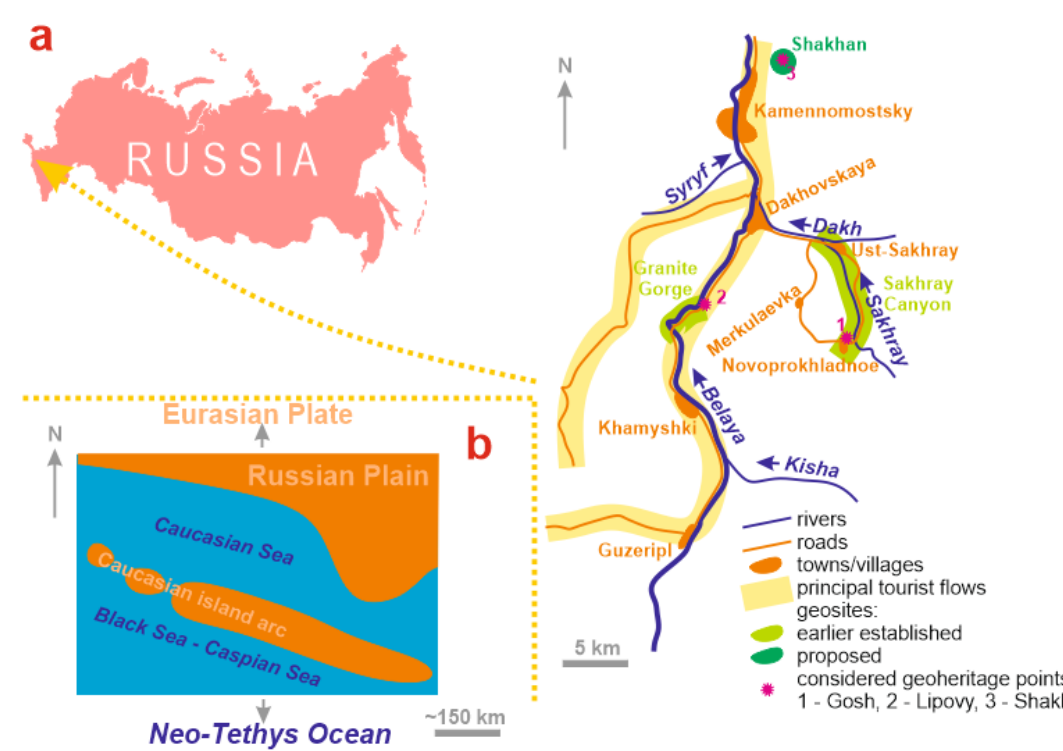
Figure 1. Geographical location of the study area, with focus on touristic infrastructure and geoheritage ( a ), and the general outline of the Mesozoic Caucasian Sea between the rather stable landmass in the north and the active island arc in the south ( b ).